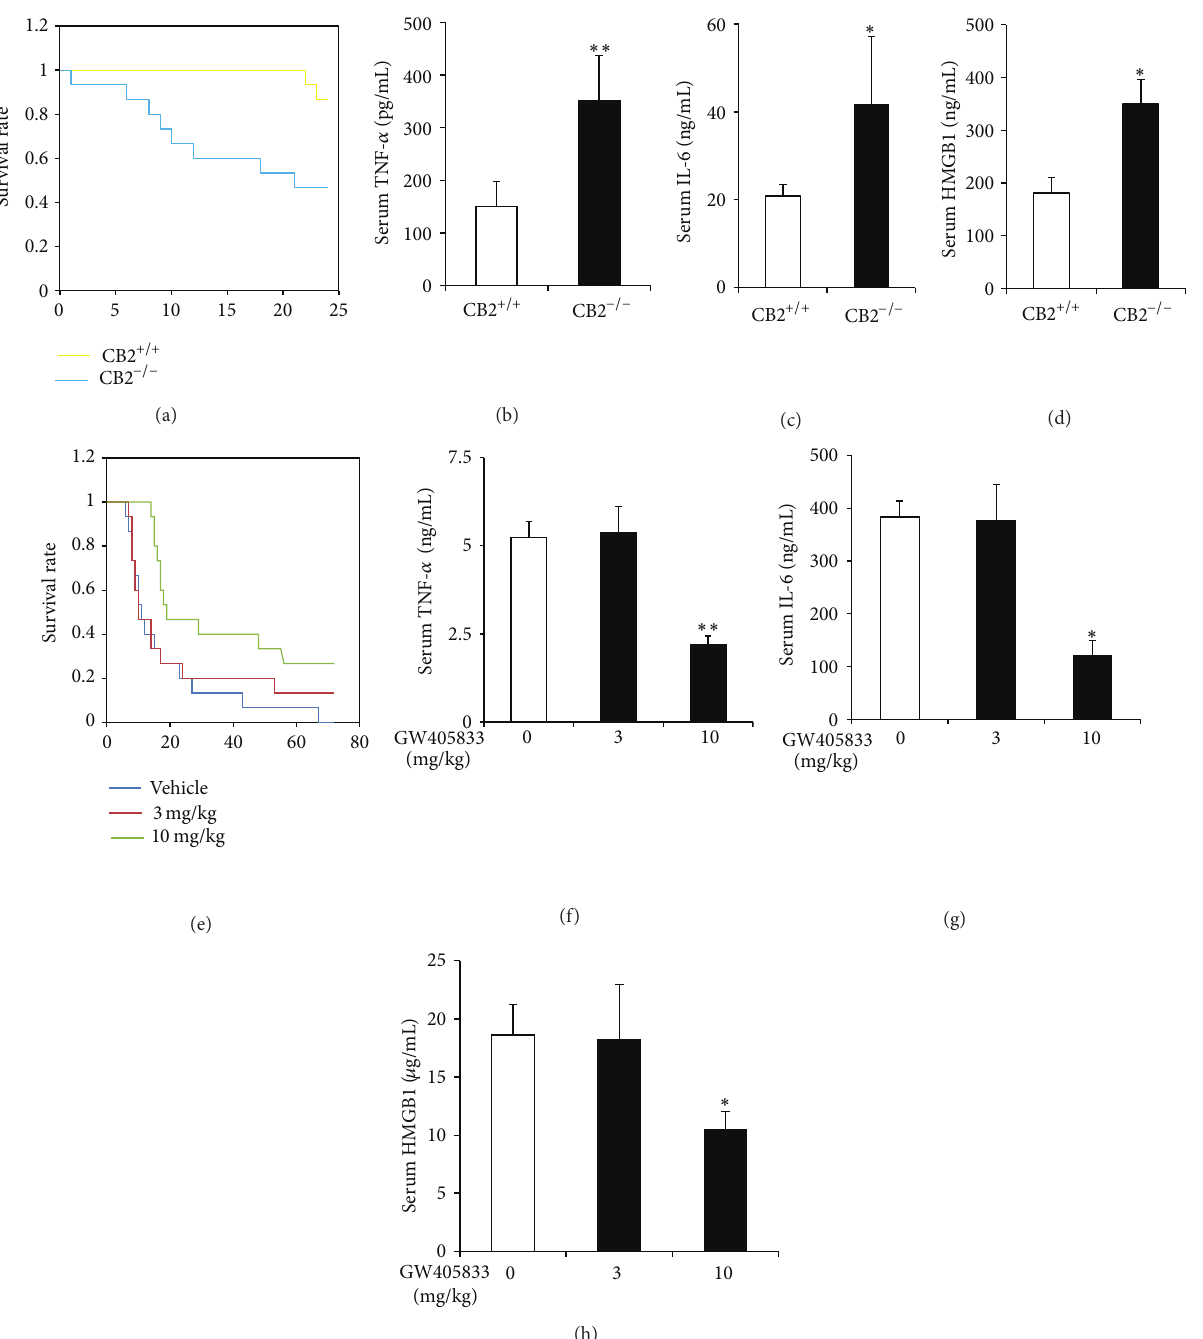
Figure 1: CB2R protects against LPS-induced shock and proinflammatory cytokines production in mice. (a) CB2R +/+ ( 𝑛 = 15 ) and CB2R −/−